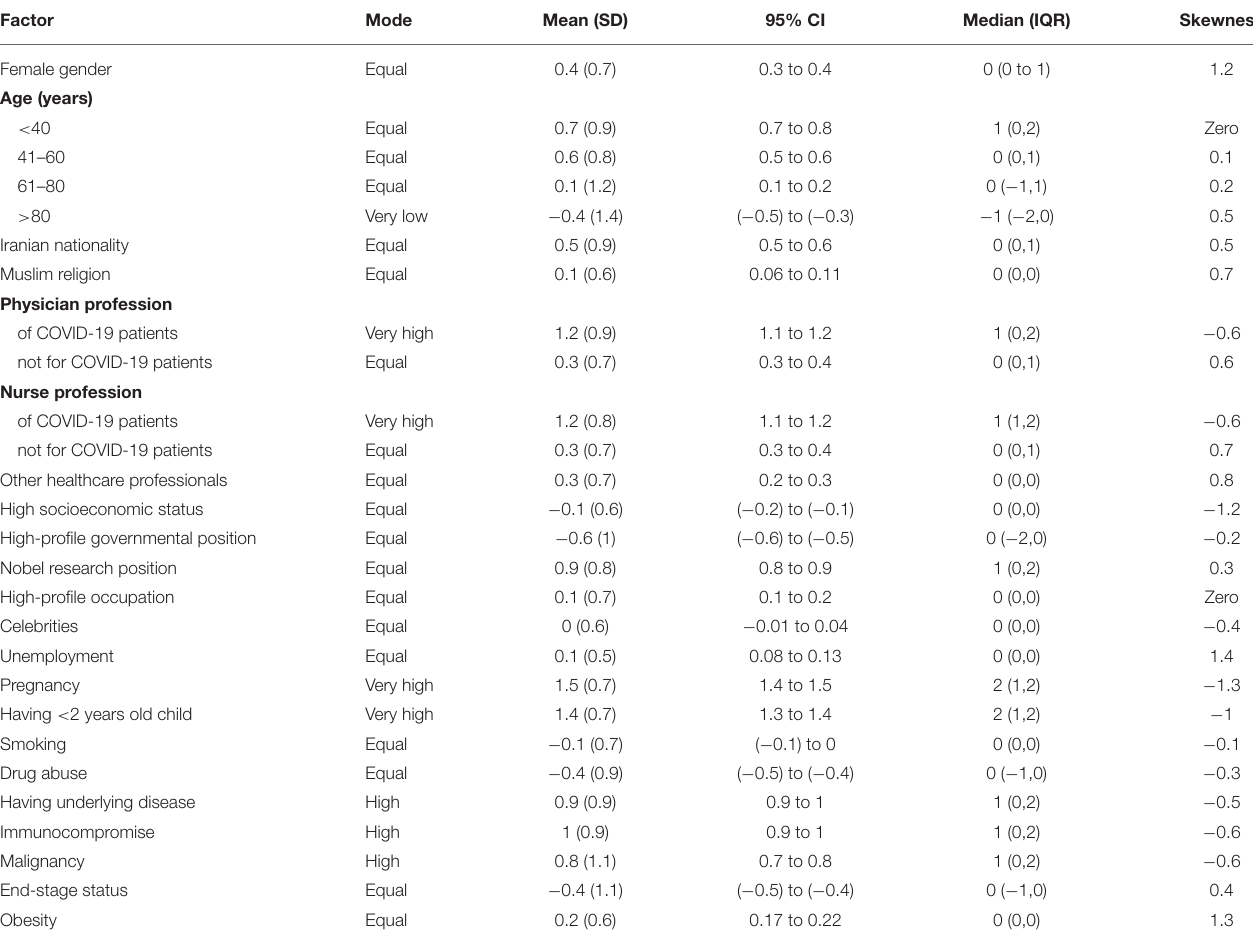
TABLE 3 | Dispersion measures of participants’ responses on prioritizing ventilator allocation among sub-groups of patients with COVID-19 who need mechanical ventilation.